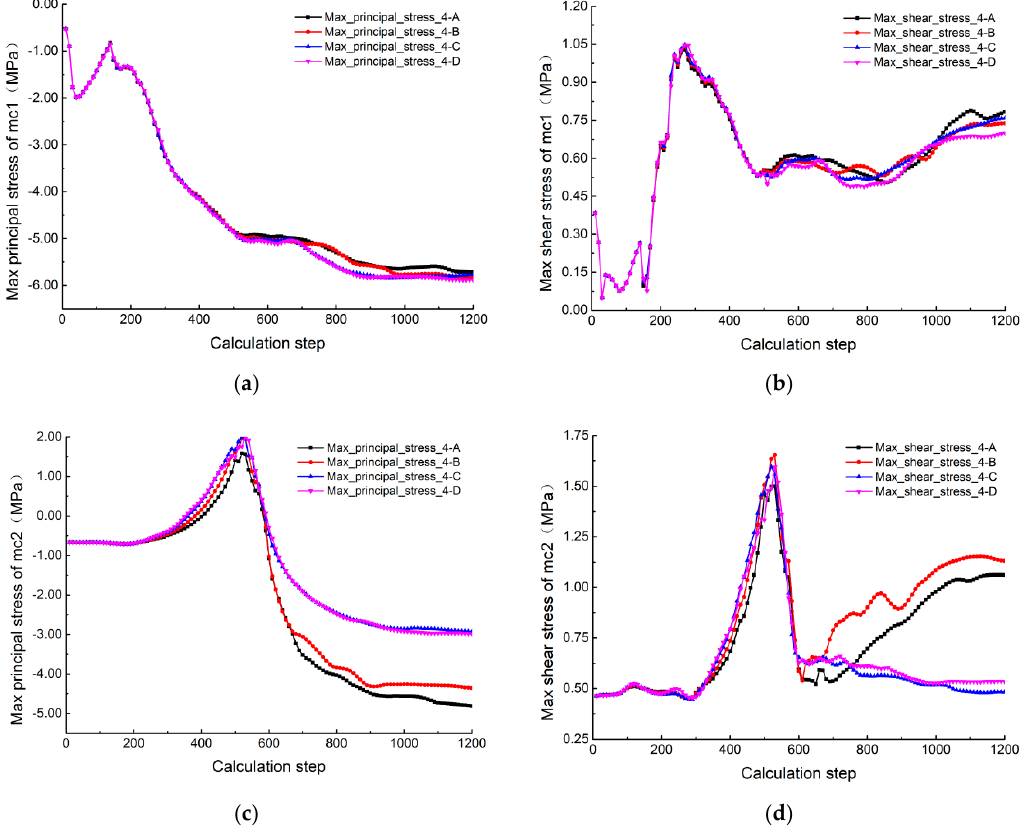
Figure 18. Principal stress curves under different WP elastic modulus values (45° and 9.8 MPa): ( a ) max principal stress history curve of Mc1; ( b ) max shear stress history curve of Mc1; ( c ) max principal stress history curve of Mc2; and ( d ) max shear stress history curve of Mc2.